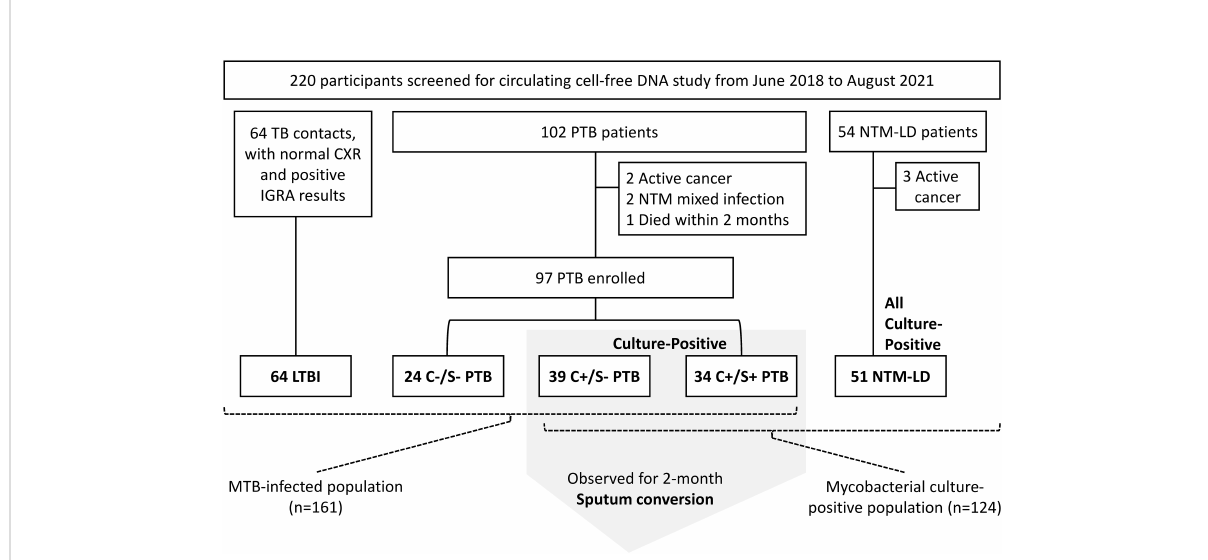
FIGURE 1 Flow chart of participant enrollment. C+, culture-positive; C-, culture-negative; S+, smear-positive; S-, smear-negative; LTBI, latent tuberculosis infection; NTM-LD, nontuberculous mycobacterial lung disease; PTB, pulmonary